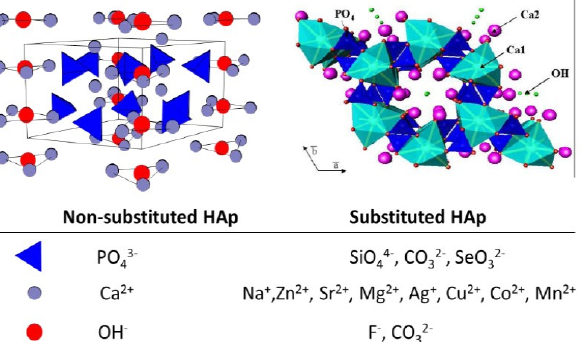
Figure 1. Simple, non–substituted hydroxyapatite and its structure ( left ) and possible ionic substitutions in the structure of hydroxyapatite ( right ). Reproduced with permission from Arcos Daniel et al., 2021 [91].